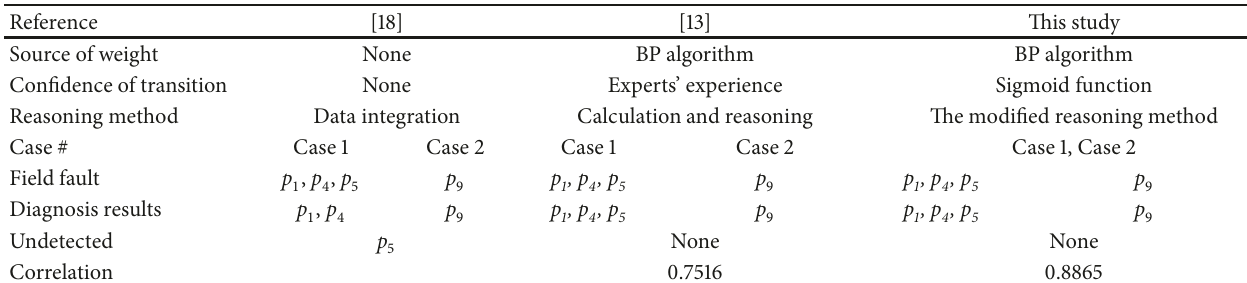
Table 2: Comparison and validation of different